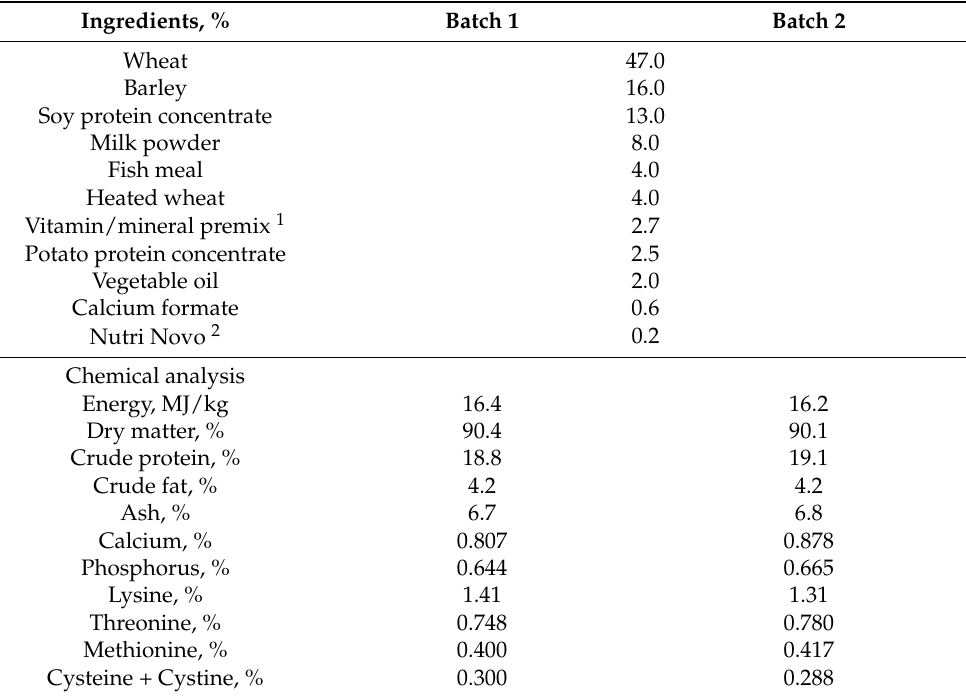
Table 1. Ingredients and composition of the dry meal creep feed offered to the piglets from day 10–24